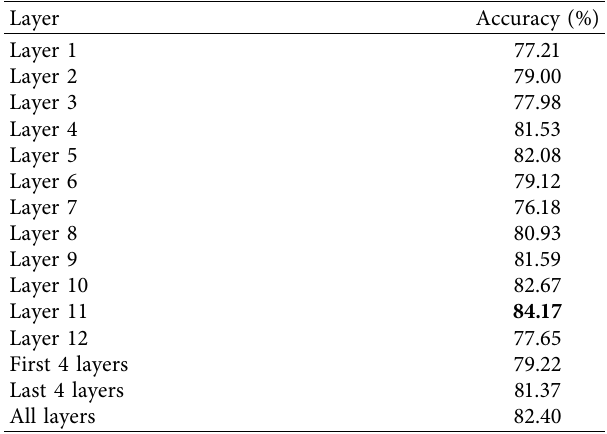
Figure 4: Results with different max sentence length on KBP2017 dataset. Table 2: Fine-tuning BERT with different layers on KBP2017 dataset.